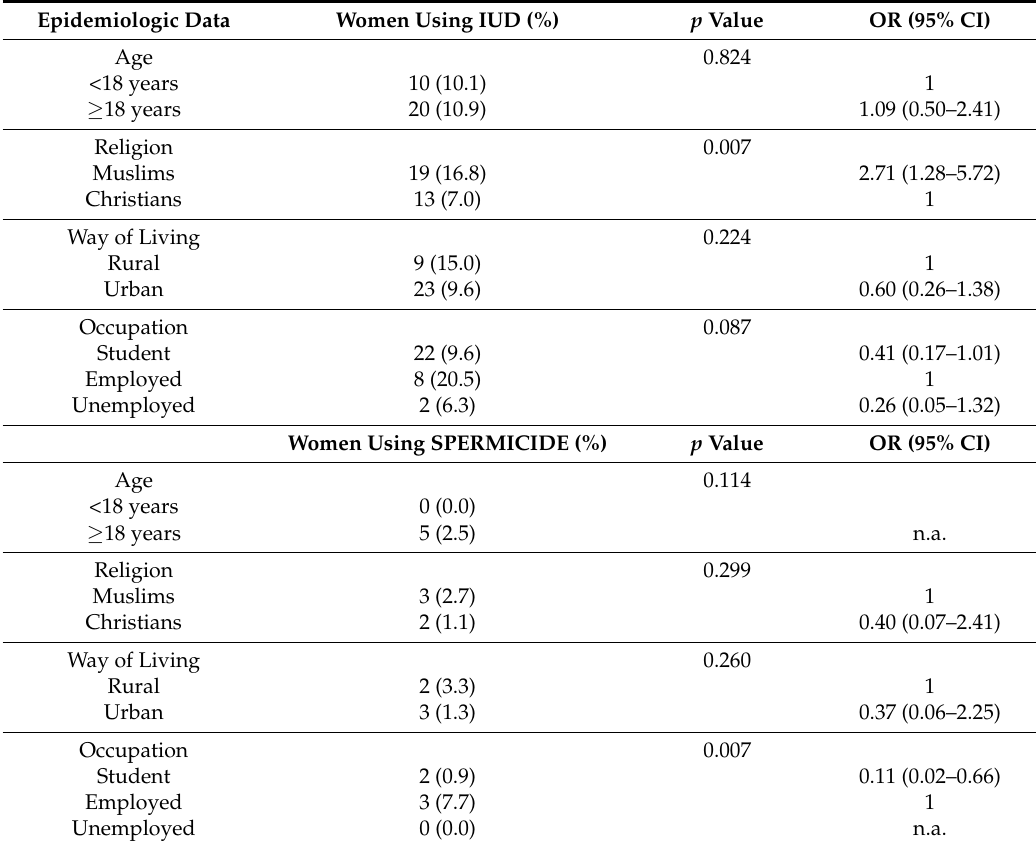
Table 5. Use of IUD and spermicides according to women’s characteristics.